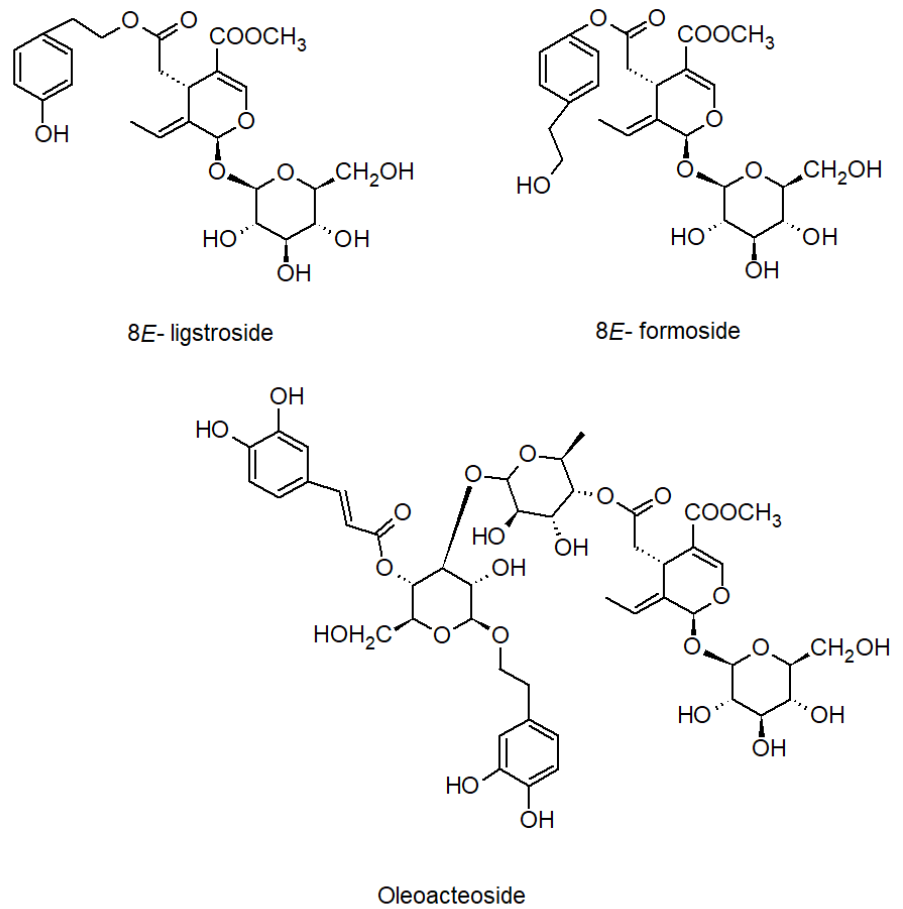
Figure 5. Structure of isolated compounds.